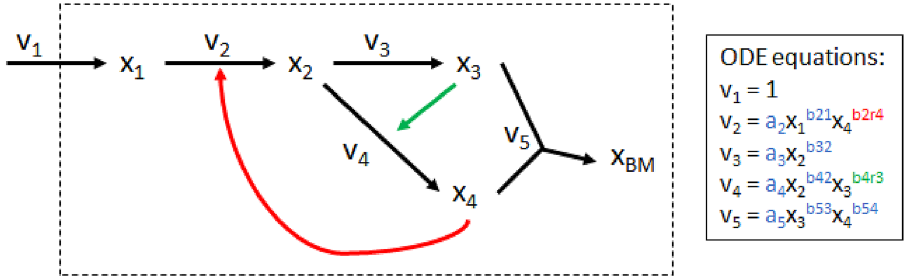
Figure 1. Synthetic model. Adapted from another branched pathway model used in previous work 11 . v 1 , v 2 , v 3 , v 4 , and v 5 are system fluxes (black arrows) and x 1 , x 2 , x 3 , x 4 , and x BM are metabolites, where x BM is a metabolite representing biomass. Green and red arrows represent positive and negative regulatory interactions,